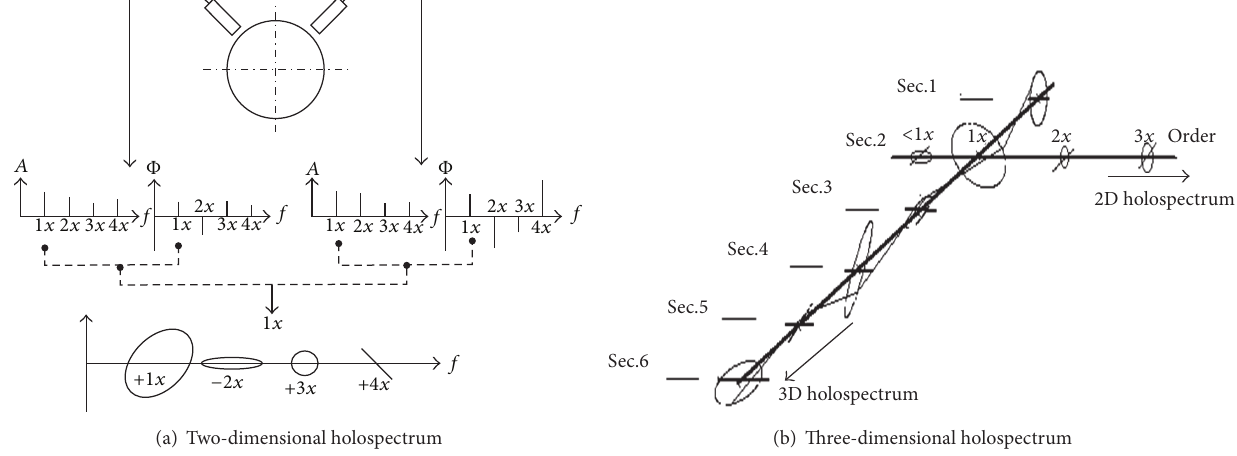
Figure 1: Structure of